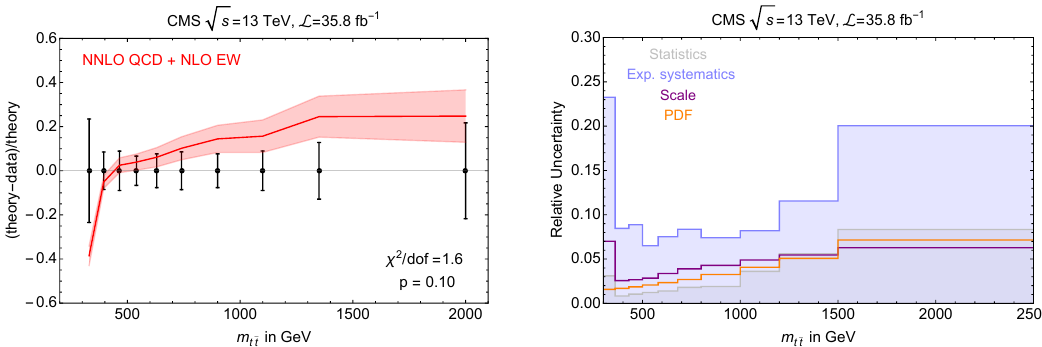
Figure 1 . Left : comparison of theory prediction to experimental data from ref. [43]. Right : summary of theory uncertainties from ref. [48] and experimental uncertainties from ref. [43]. The uncertainties on both plots are 1 (cid:27)